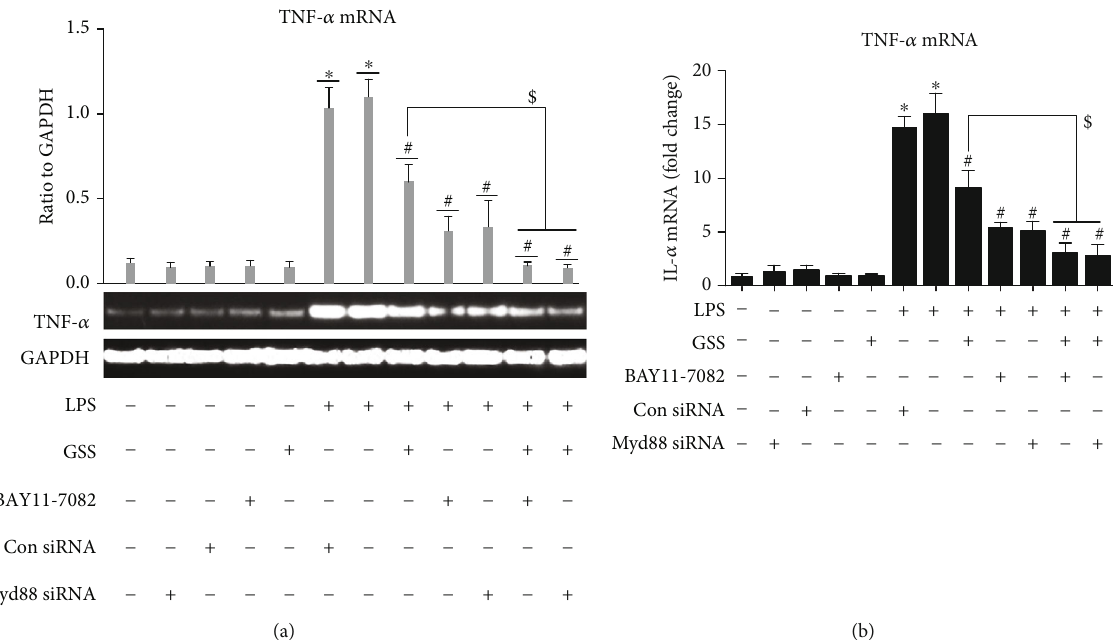
Figure 8: GSS inhibit LPS-induced TNF- α expression in ECs via Myd88/NF- κ B signaling pathway. (a) After transfection with Myd88 siRNA for 48 hours, ECs were treated with GSS for another 2 hours prior to the stimulation of LPS; the expression of TNF- α was determined by RT- PCR. Similarly, ECs were pretreated with BAY11-7082 (10 μ mol/l) and GSS for 2 hours and then incubated with LPS; the TNF- α expression was checked by RT-PCR. (b) The RT-qPCR results of TNF- α were presented as a histogram. The relative amount was normalized to the housekeeping gene GAPDH. ∗ P < 0 : 05 versus negative control. # P < 0 : 05 versus the corresponding LPS treatment group. $ P < 0 : 05 versus the corresponding GSS treatment